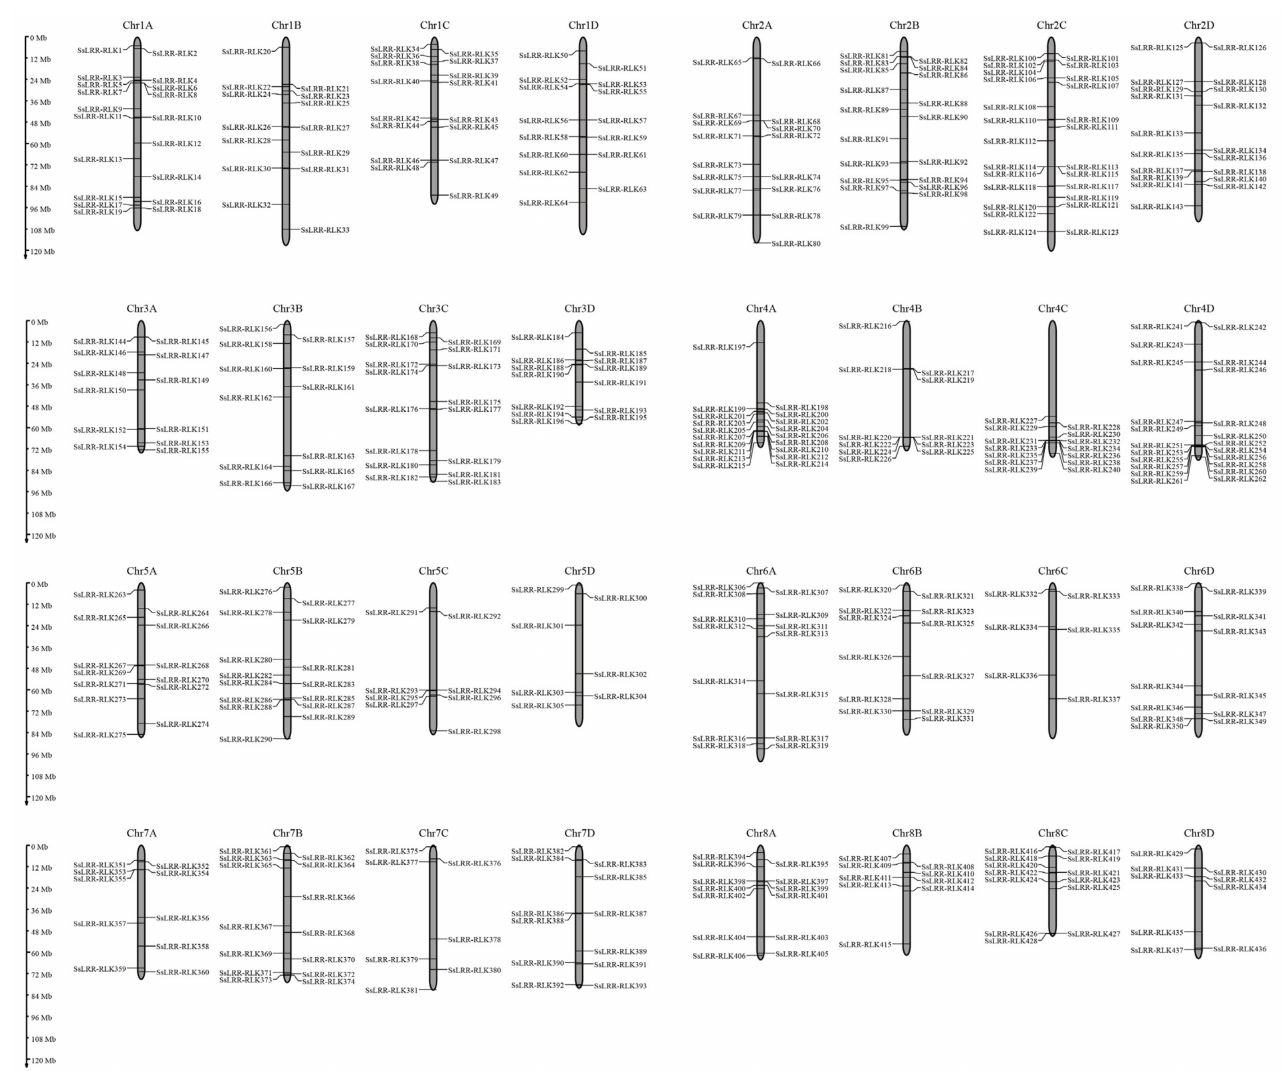
Figure 1. Chromosome distribution of LRR-RLK family in S. spontaneum . 437 SsLRR-RLK alleles were located in all 32 chromosomes. The figure was drawn using MG2C